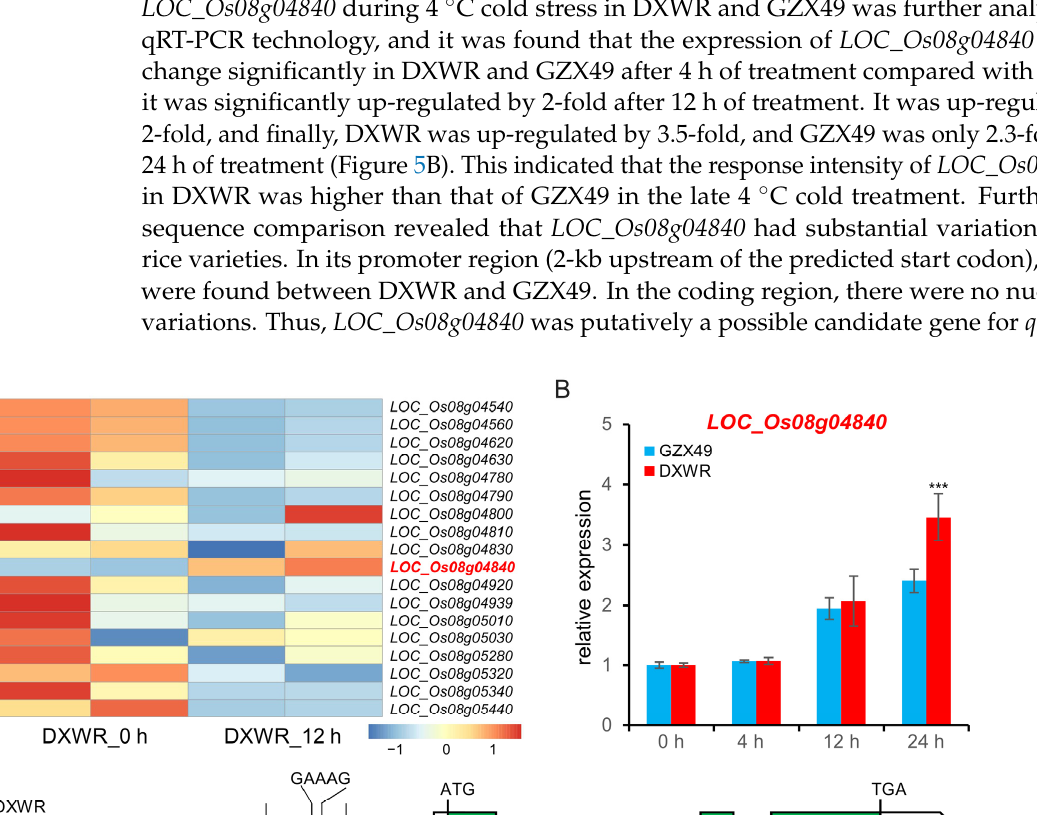
Figure 4. Transcriptome analysis of the genetic mechanism of DXWR in response to cold stress. ( A ) Differentially expressed gene statistics. ( B , C ) are Venn diagrams of up-regulated and down-regu- lated genes, respectively. ( D , E ) are gene ontology (GO) functional enrichment histogram and Kyoto encyclopedia of genes and genomes (KEGG) pathway enrichment histogram, respectively. 0_4,